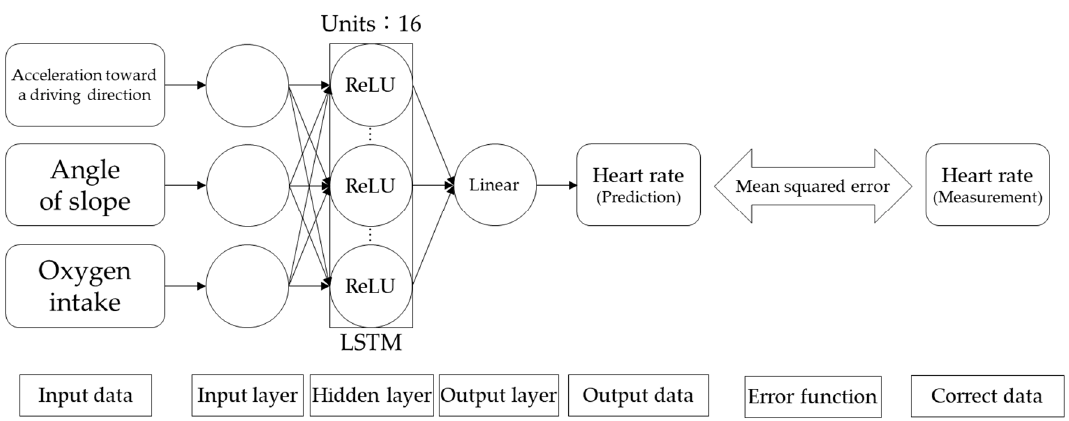
Figure 5. Model for heart rate estimation.